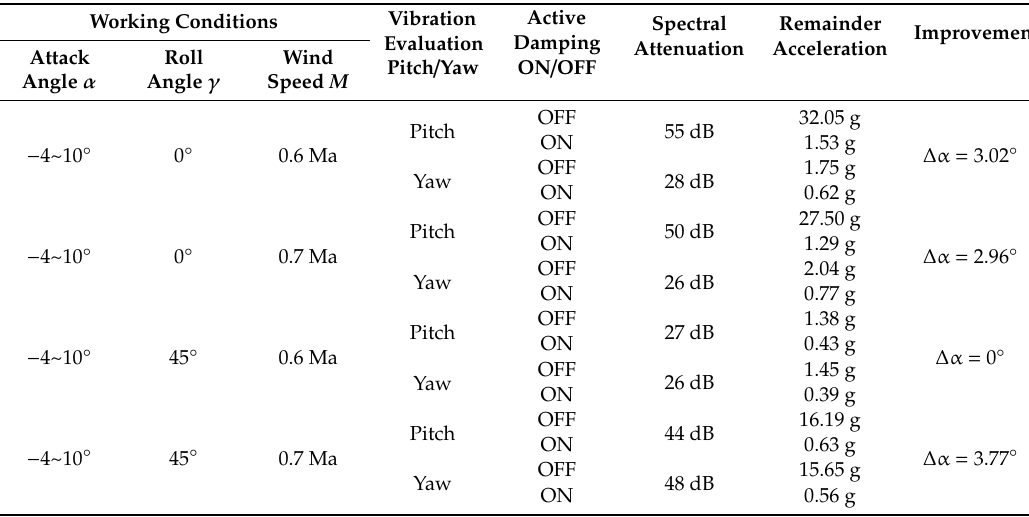
Table 3. Verification results in wind tunnel.